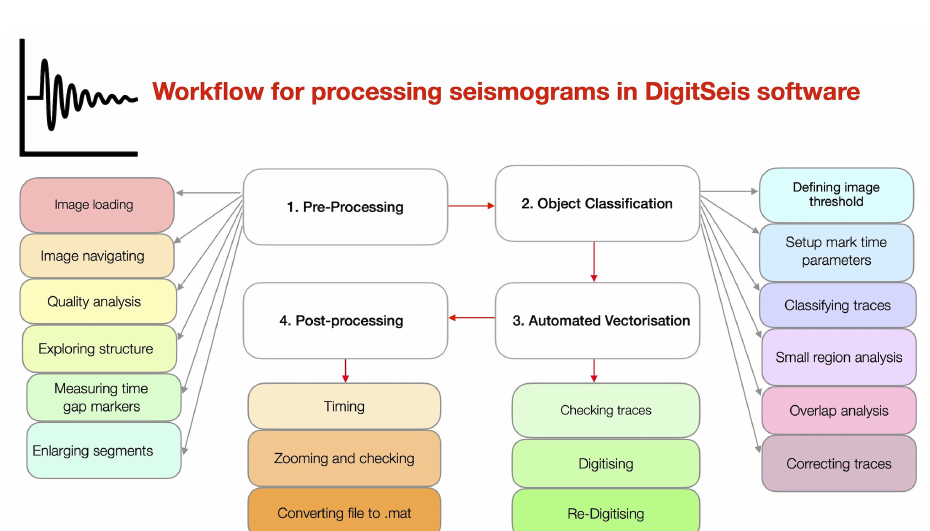
Figure 5. Pipeline schematic diagram for workflow process for vectorising